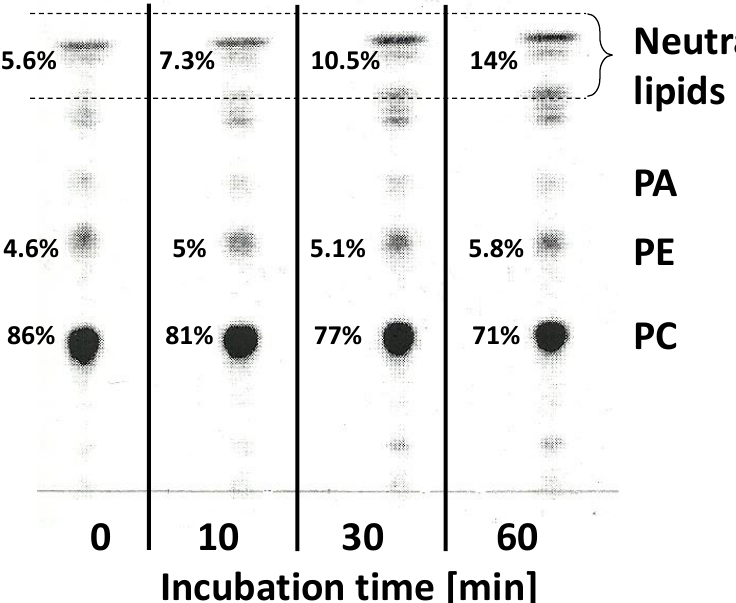
Figure 9. Distribution of radioactivity from added [ 14 C]18:2-CoA by different lipid classes (separated on TLC with polar solvent) during incubation of the microsomal fraction of developing seeds of Momordica charantia . Microsomes were pre-incubated for 10 min with [ 14 C]18:2-CoA without NADH (indicated on graph as 0 min incubation time). Afterwards, a new buffer with NADH was added to the pelleted microsomes and incubated for the remaining time. X% = percentage of [ 14 C] per line (mean values from duplicates). Abbreviations: PA—phosphatidic acid, PE—phosphatidylethanolamine, PC—phosphatidylcholine.